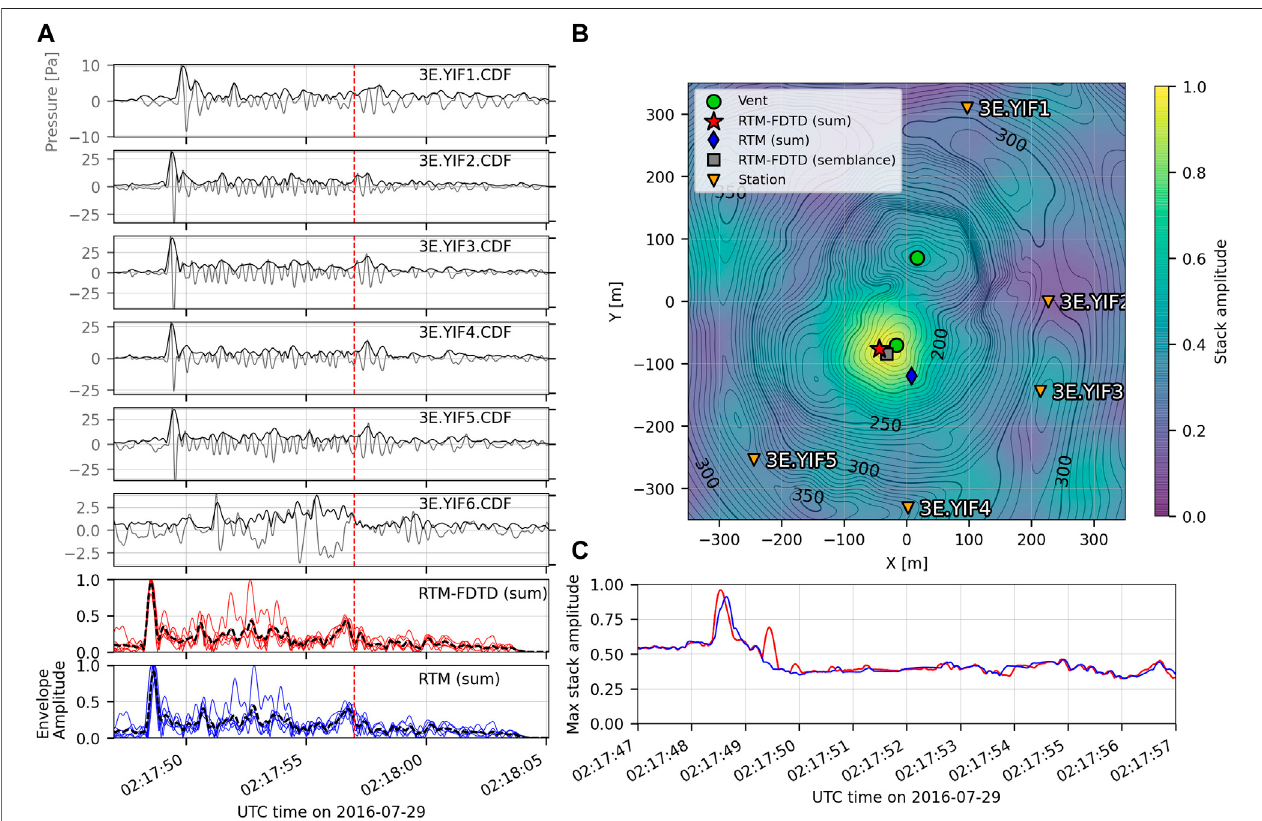
FIGURE3| YasurVentAexplosionwaveformsandRTMandRTM-FDTDlocationcomparison. (A) Graywaveformsare fi lteredbetween0.2to4 Hzwhiletheblack envelopeistheprocessedwaveformsfortheRTMalgorithm(seetextfordetails).Thebottomtwopanelsarethetraveltimeremoved,processedwaveformenvelopesfor the maximum stack location for the entire window, as indicated by the red star and blue diamond in (B) . Red lines are for RTM-FDTD (sum) and blue for RTM (sum), and theblackdashedlineisthemeanoftheenvelopes.Theverticalreddashedlineindicatestheedgeofthetimewindowforanalysis.Dataafterthispointareneededto pad for travel time removal across the entire grid. (B) Map-view slice of the RTM-FDTD (sum) stack maximum around the Yasur crater region. RTM-FDTD (semblance) location is indicated by a gray square and RTM (sum) location by ablue diamond. The green circles denotes the two vent locations and inverted orange trianglesdenote station locations. (C) Maximum stackamplitudeover time forRTM-FDTD(sum)inred and RTM(sum)inblue. Themaximum oftheRTM-FDTD(sum) corresponds tothe sliceshownin (B) .Thetimewindowin (C) correspondstothe10 spriortotheredlinein (A) .BothRTM-FDTDimplementationslocatethesourcetowithinapproximately 20 m of the assumed vent location, and the RTM-FDTD algorithm provides better waveform alignment and higher stack amplitudes. The RTM algorithm locates the source 53 m to the southeast.